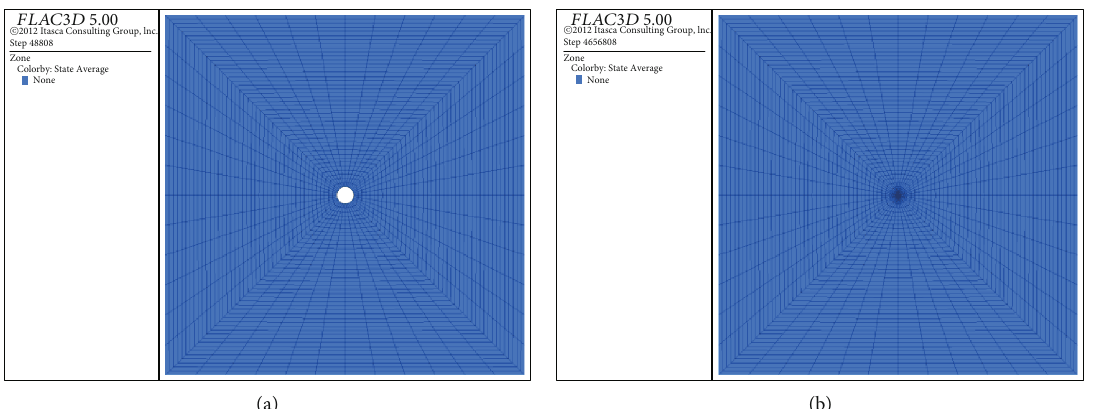
Figure 11: The plastic zone at di ff erent stages of the numerical model: (a) After excavation of tunnel; (b) The tunnel after 100 years of buried waste tank.